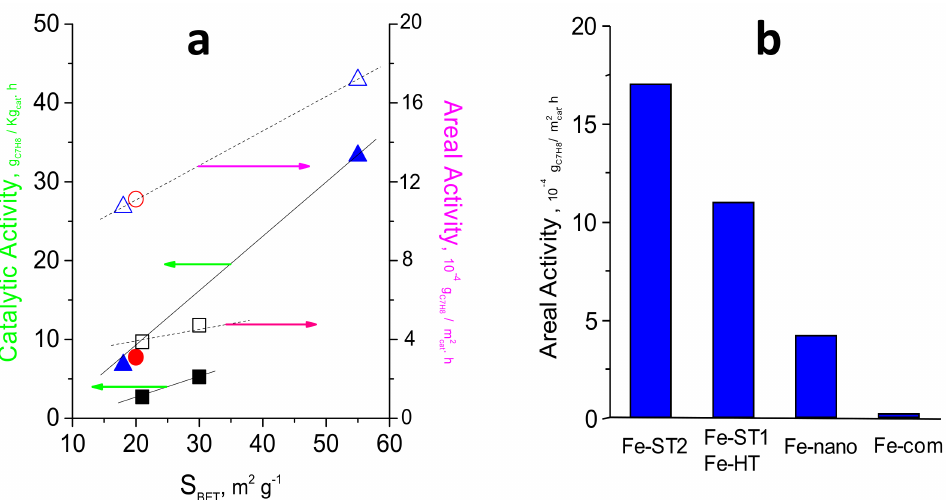
Figure 9. ( a ) Influence of the preparation method and the surface area of the FeOx prepared catalysts on the catalytic activity per gram of catalyst and on the catalytic activity per surface area in the toluene oxidation. ( b ) compares the values of the areal activity for the most efficient catalysts prepared in the present work with those of a high surface area Fe-nano and the commercial Fe-com. Note: 275 ◦ C, GHSV = 300,000 h − 1 and remaining reaction conditions detailed in the text. Symbols: Open symbols correspond to catalytic activity per surface area. Filled symbols correspond to catalytic activity per gram of catalyst. ( ∆ , (cid:78) ) solvothermal method, ( ◦ , • ) hydrothermal method, ( (cid:3) , (cid:4) ) supercritical water